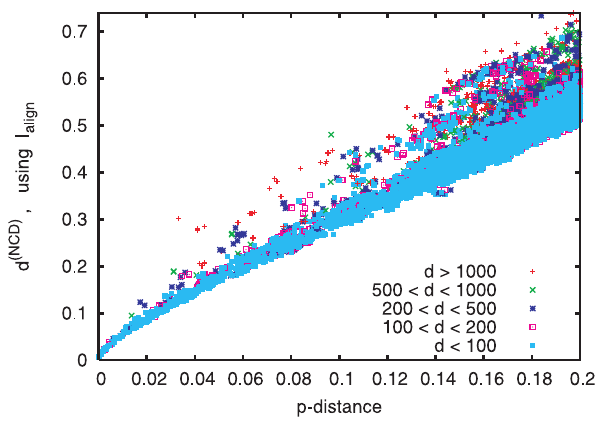
Figure 5. Scatter plot comparing p-distances d ( p ) to normalized AB compression distances d ( NCD ) obtained from I align . The figure is AB based on & 10 5 mtDNA pairs, selected according to criteria discussed in the main text. Different symbols correspond to different length differences d ~ D N A { N B D , where N A and N B are the original (non- aligned) sequence lengths.